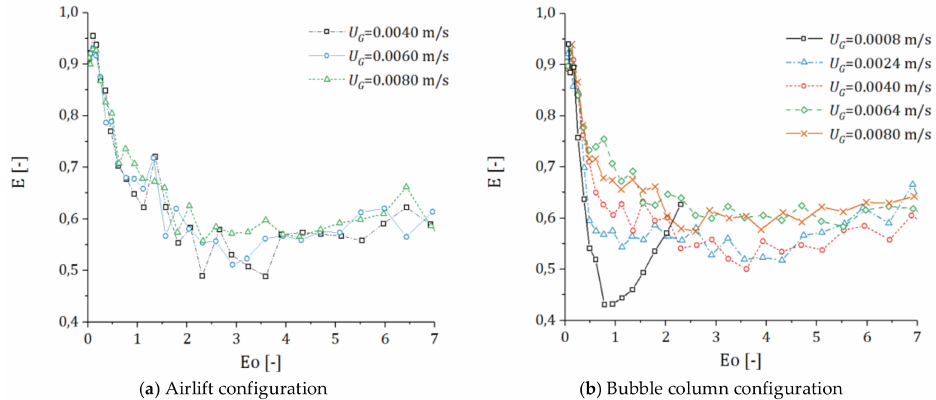
Figure 25. Influence of the gas superficial velocity (HZDR, Helmholtz-Zentrum Dresden-Rossendorf, bubble columns) on the E -batch mode only.